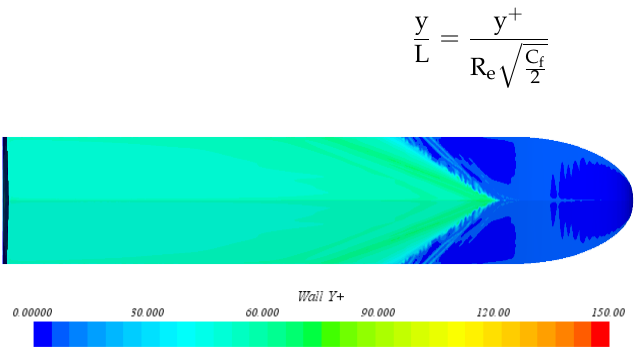
Figure 6. Visualization of y+ bare hull at Fr 1.78.